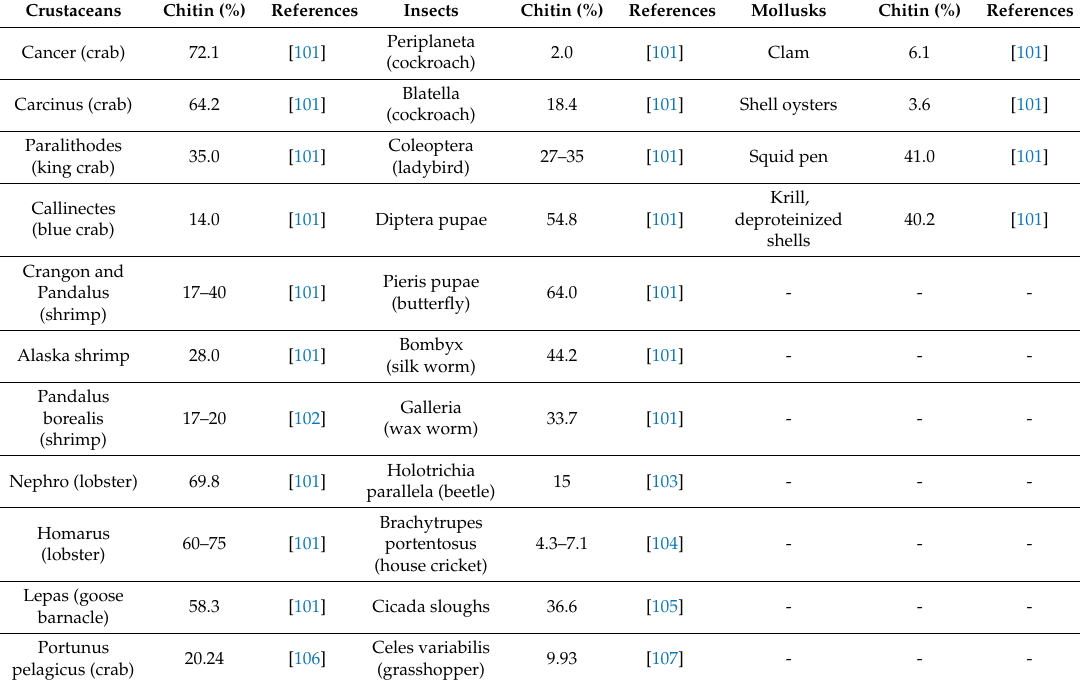
Table 5. Typical types of animal for chitin sourcing and their chitin contents.